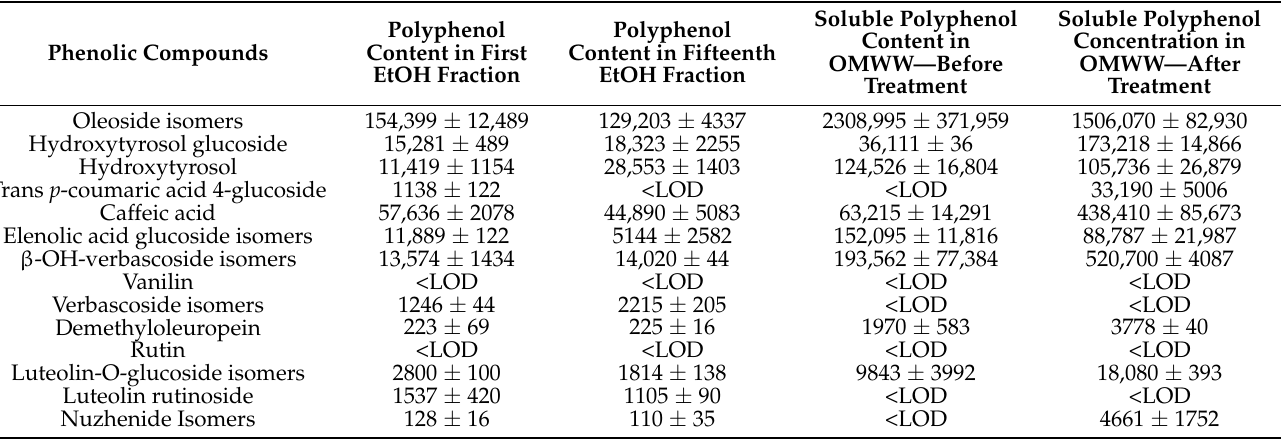
Table 4. Polyphenol quantities for fifteen subsequent treatments of OMWW with Fe 3 O 4 particles modified with citric acid. The particles were thereafter desorbed in EtOH. Total concentrations of polyphenolic compounds are quantified in mg per mL of OMWW; individual compounds are semi-quantified (using counts from the MS